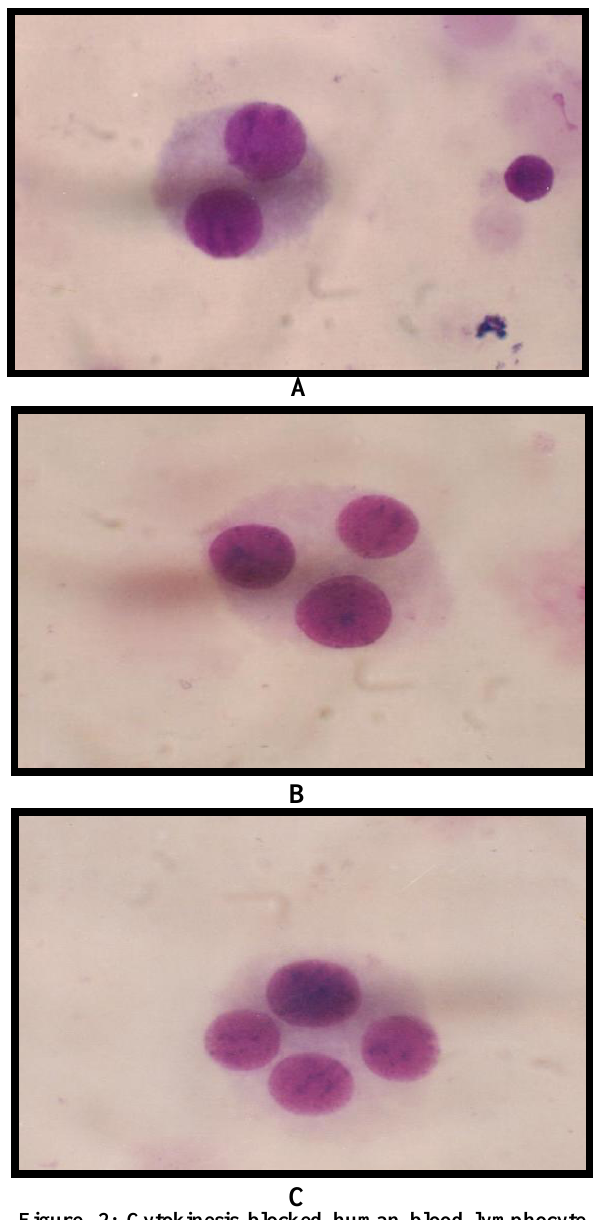
Figure, 2: Cytokinesis blocked human blood lymphocyte cell, A: Binucleated lymphocyte cell, B: Trinucleated lymphocyte cell and C: Qudrinucleated lymphocyte cell